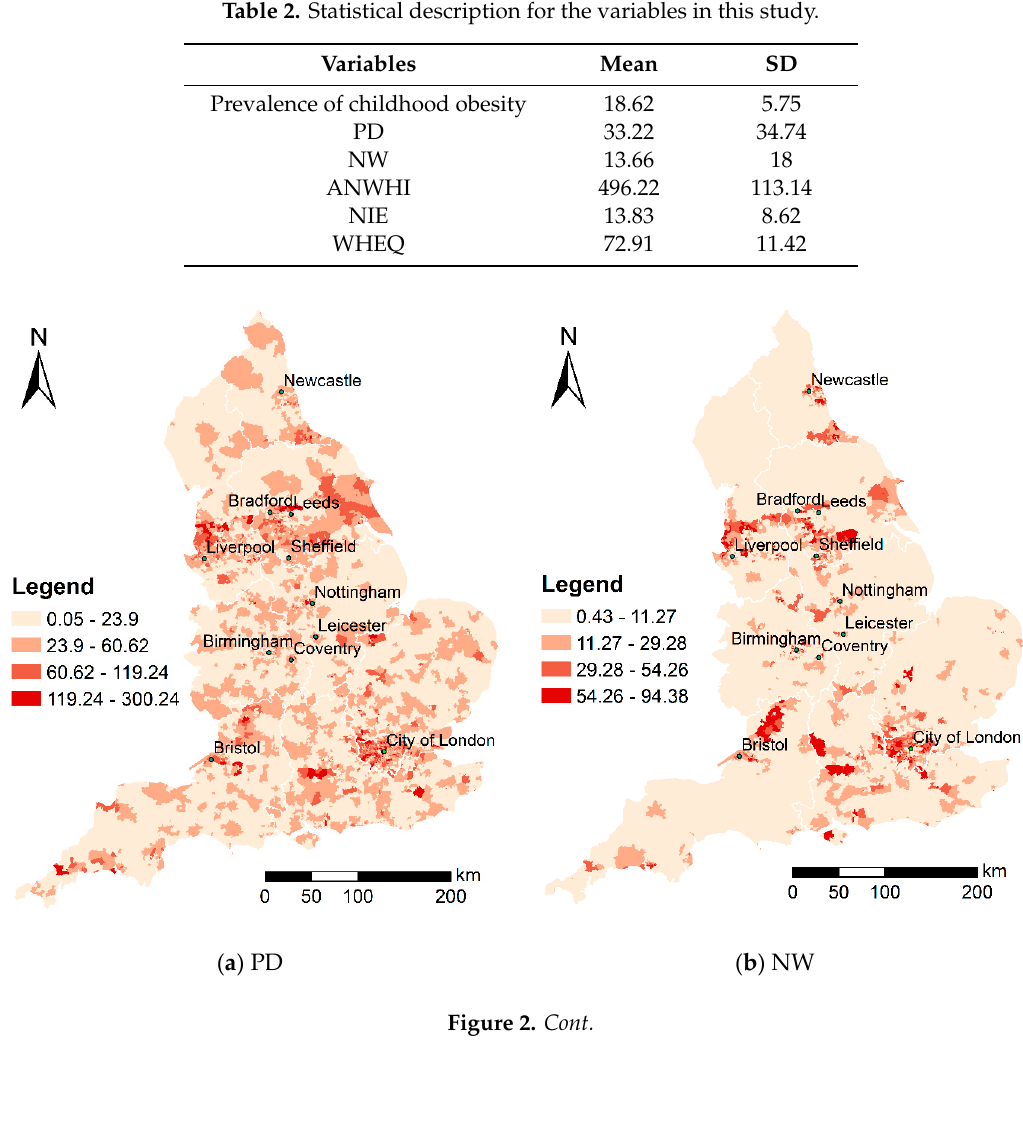
Table 2. Statistical description for the variables in this study.